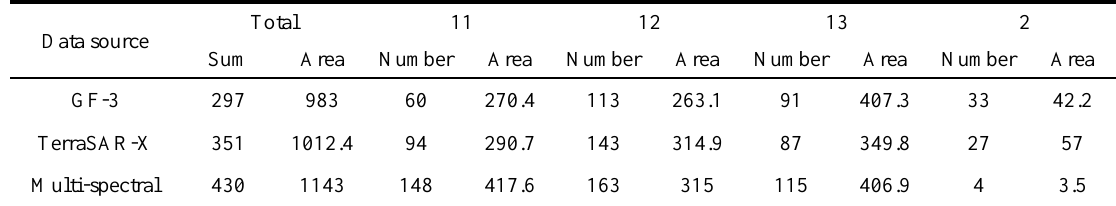
Table 7. Statistics of the number and area of the four types of change objects (Area Unit: ha)